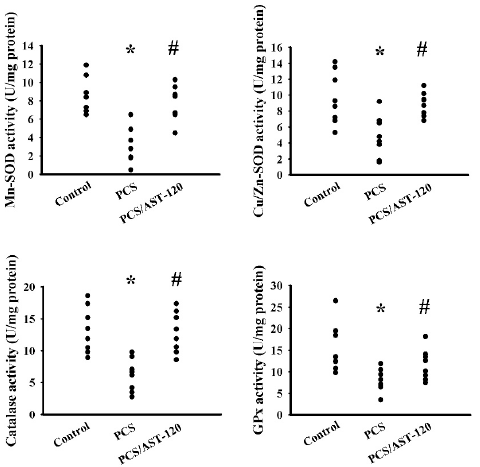
Figure 8. PCS decreased antioxidant enzyme activities. Unilateral nephrectomized mice were intraperitoneally injected with PCS (0, Control; and 100 mg/kg, PCS) and the PCS-injected mice were orally given with AST-120 (400 mg/kg, PCS/AST-120) for 7 weeks. The prefrontal cortical tissues were collected and subjected to the measurement of Mn-SOD activity, Cu / Zn-SOD activity, catalase activity, and GPx activity. * p < 0.05 vs. control group and # p < 0.05 vs. PCS group, n =